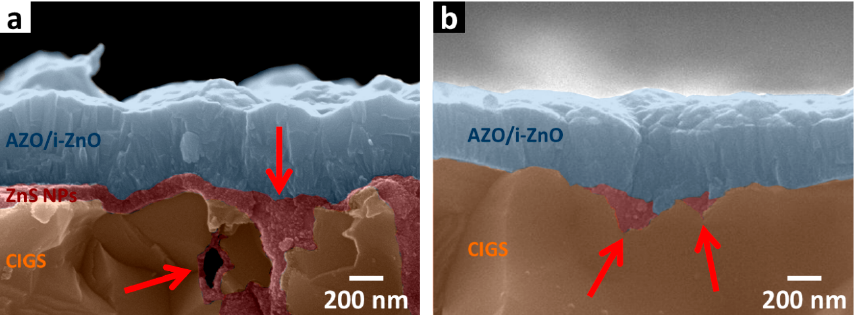
Figure 4. ( a ) Cross-sectional SEM images of CIGS solar cells with ( a ) thick and ( b ) thin layer of ZnS NPs. CIGS. ZnS NPs, and the AZO/i-ZnO window layer have been correspondingly labeled by brown, red and blue shades, while ZnS NPs coated in valley and air voids are particularly indicated by the red arrows.